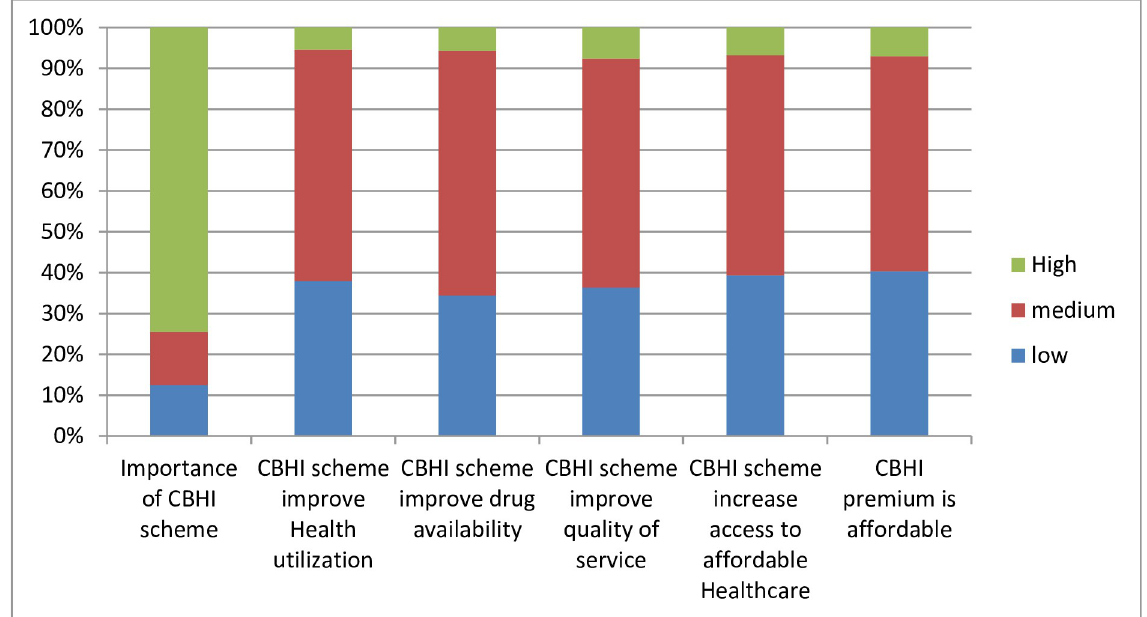
Fig 2. Respondents’ perception towards community based health insurance scheme,